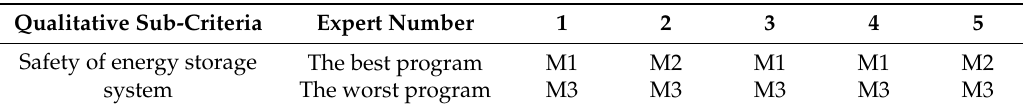
Table 3. The best and the worst micro-grid planning programs of safety of energy storage system selected by 5 experts.